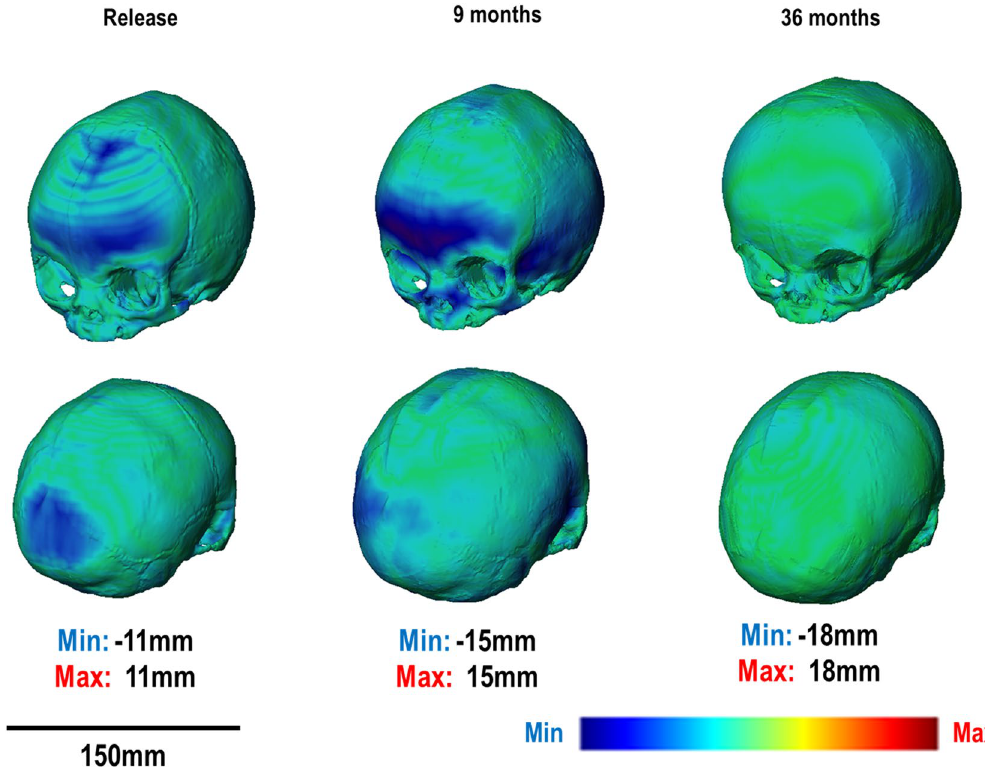
Figure 5. 3 SAC 3D distance plot at respective ages against mean in vivo CT skull.